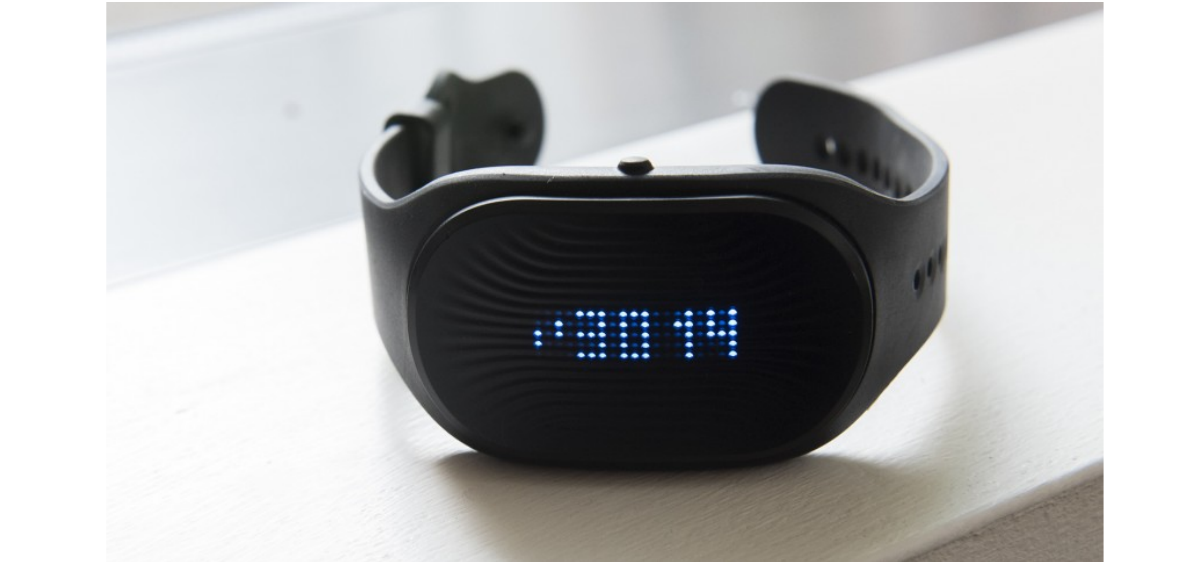
Figure 1. Healbe GoBe2